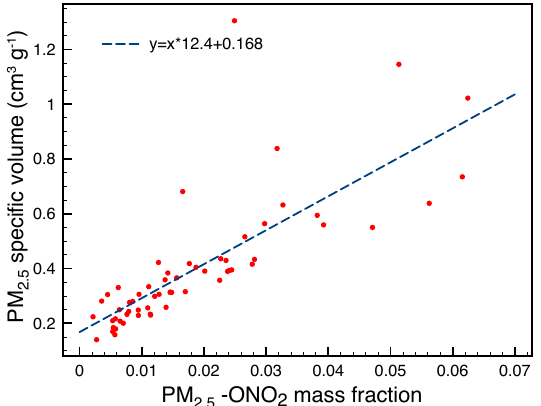
Figure 4. Correlation of specific volume (inverse density) to the mass fraction of the aerosol organic nitrate for PM 2 . 5 size range ( R 2 =